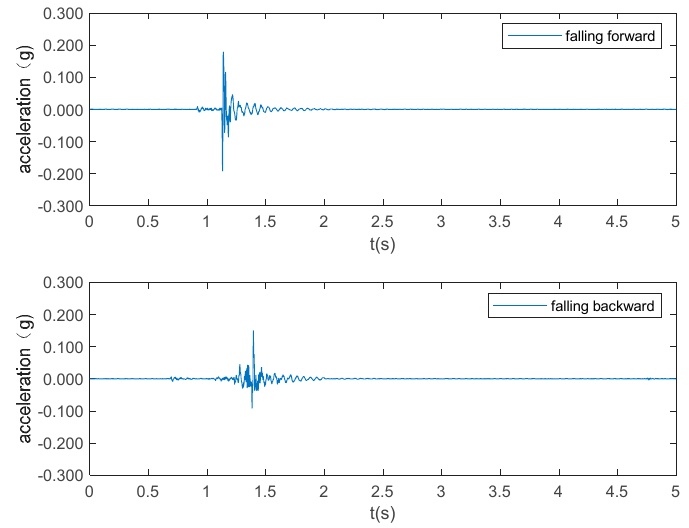
Figure 5. Dummy weighing 75 kg falls.